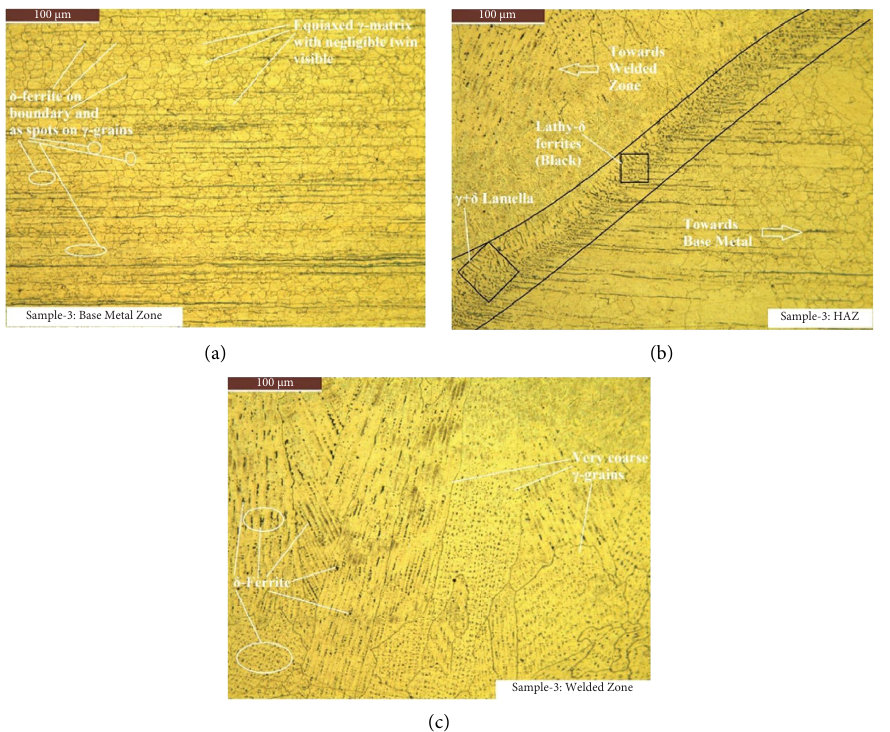
Figure 7: Microstructural appearance of sample 3 (water+ sand-cooled): (a) the base metal, (b) HAZ, and (c) welded zone.